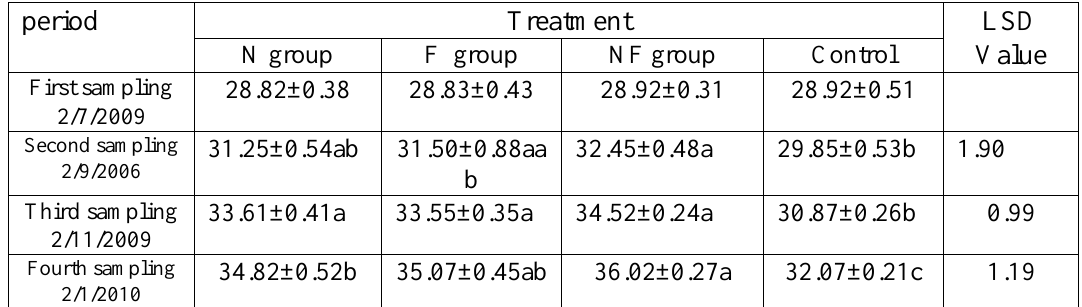
Table (5) Effect of Nigella sativa and / or Fenugreek seeds in the diet on wool fiber diameter (µ) of Awassi male lambs (means ± SE)